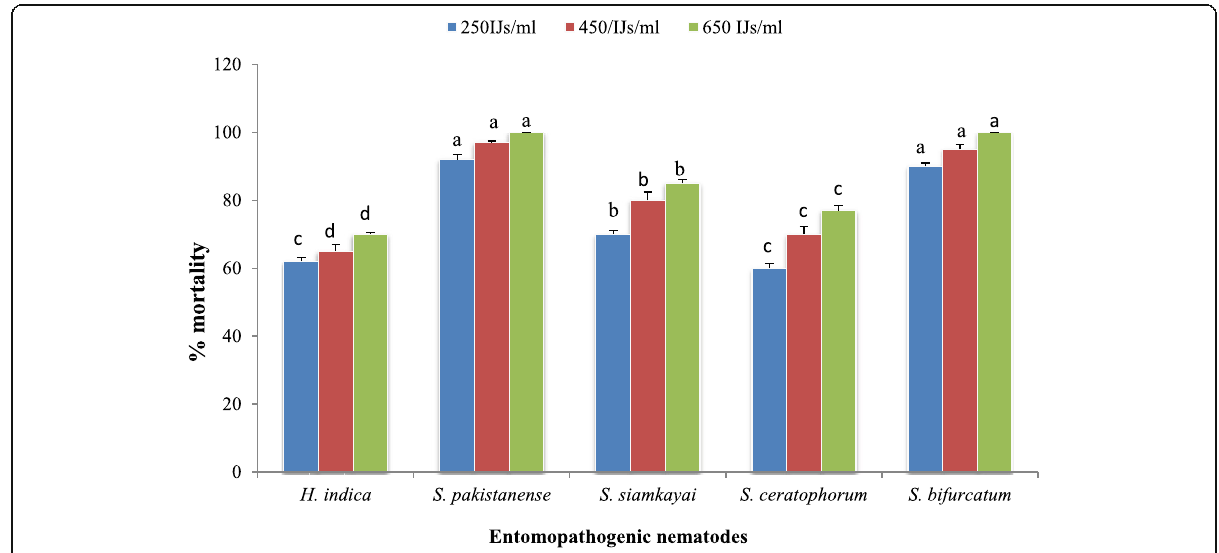
Fig. 2 Biocontrol potential of entomopathogenic nematodes against Microtermes obesi on wooden